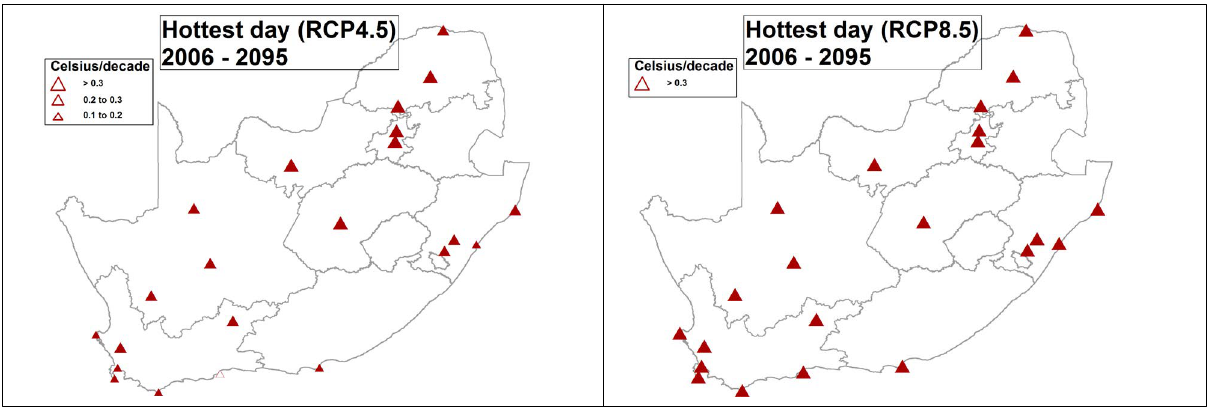
Figure 9: Trends in hottest days (TXX) in °C per decade, for the period 2006–2095 for the RCP4.5 and RCP8.5 scenarios, as indicated. Filled triangles denote significant trends at the 5%